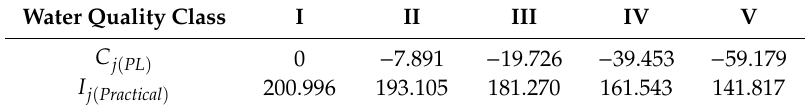
Table 3. The practical value of the exchanged water in di ff erent water quality classes (million CNY)